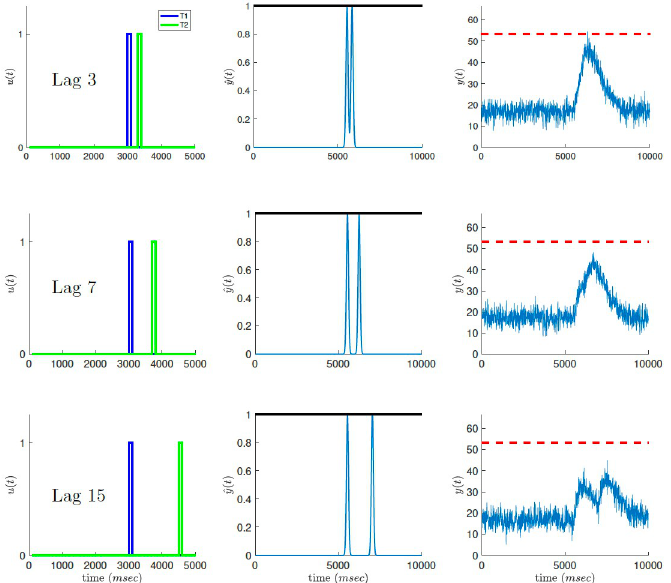
Fig 1. Attentional blink model. Input targets (left) are processed in two stages: a unit-clipped sensory trace (center, clipping threshold represented by solid black line) followed by a threshold limited allocation of attentional resources (right, blinking threshold represented by dashed red line). Top: When input targets appear in close temporal succession (here, lag 3) the output of the attentional system is more likely to cross the blinking threshold (dashed red line) resulting in reduced detection of T2 (the attentional blink). Middle: When the temporal interval between targets is longer (here, lag 7), the overlap between their attentional loads is reduced, with a lower chance of crossing the blinking threshold. Bottom: When the two targets are even further apart (lag 15), each one creates a separate peak in the attentional load and the probability of triggering an attentional blink is negligible.